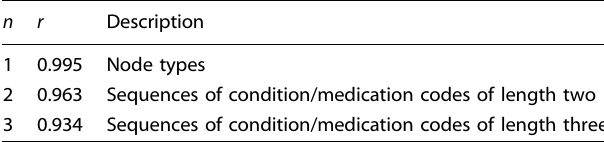
Table 2. Pearson ’ s r between the frequency of different structures in the collection of training trajectories and the collection of generated trajectories.